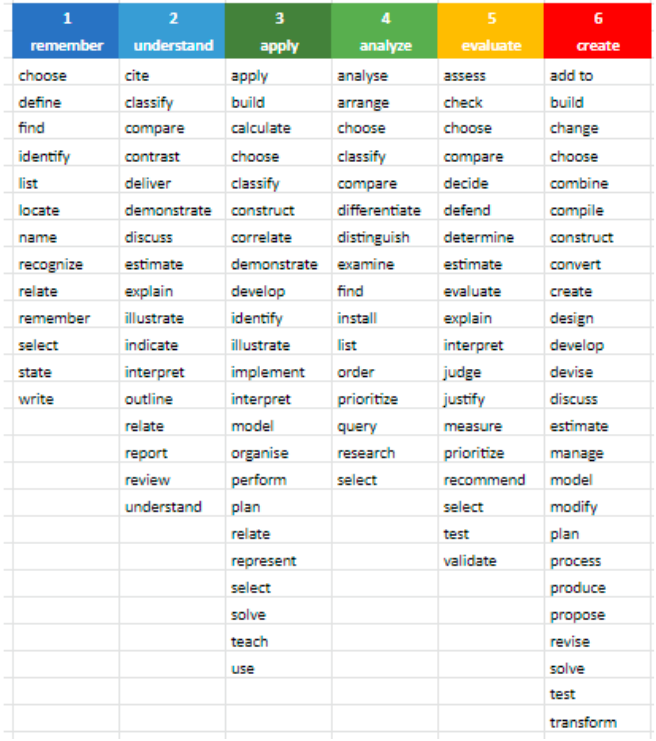
Figure 4. The list of verbs used to formulate skills in the EO4GEO BoK (Source: Hofer et al.